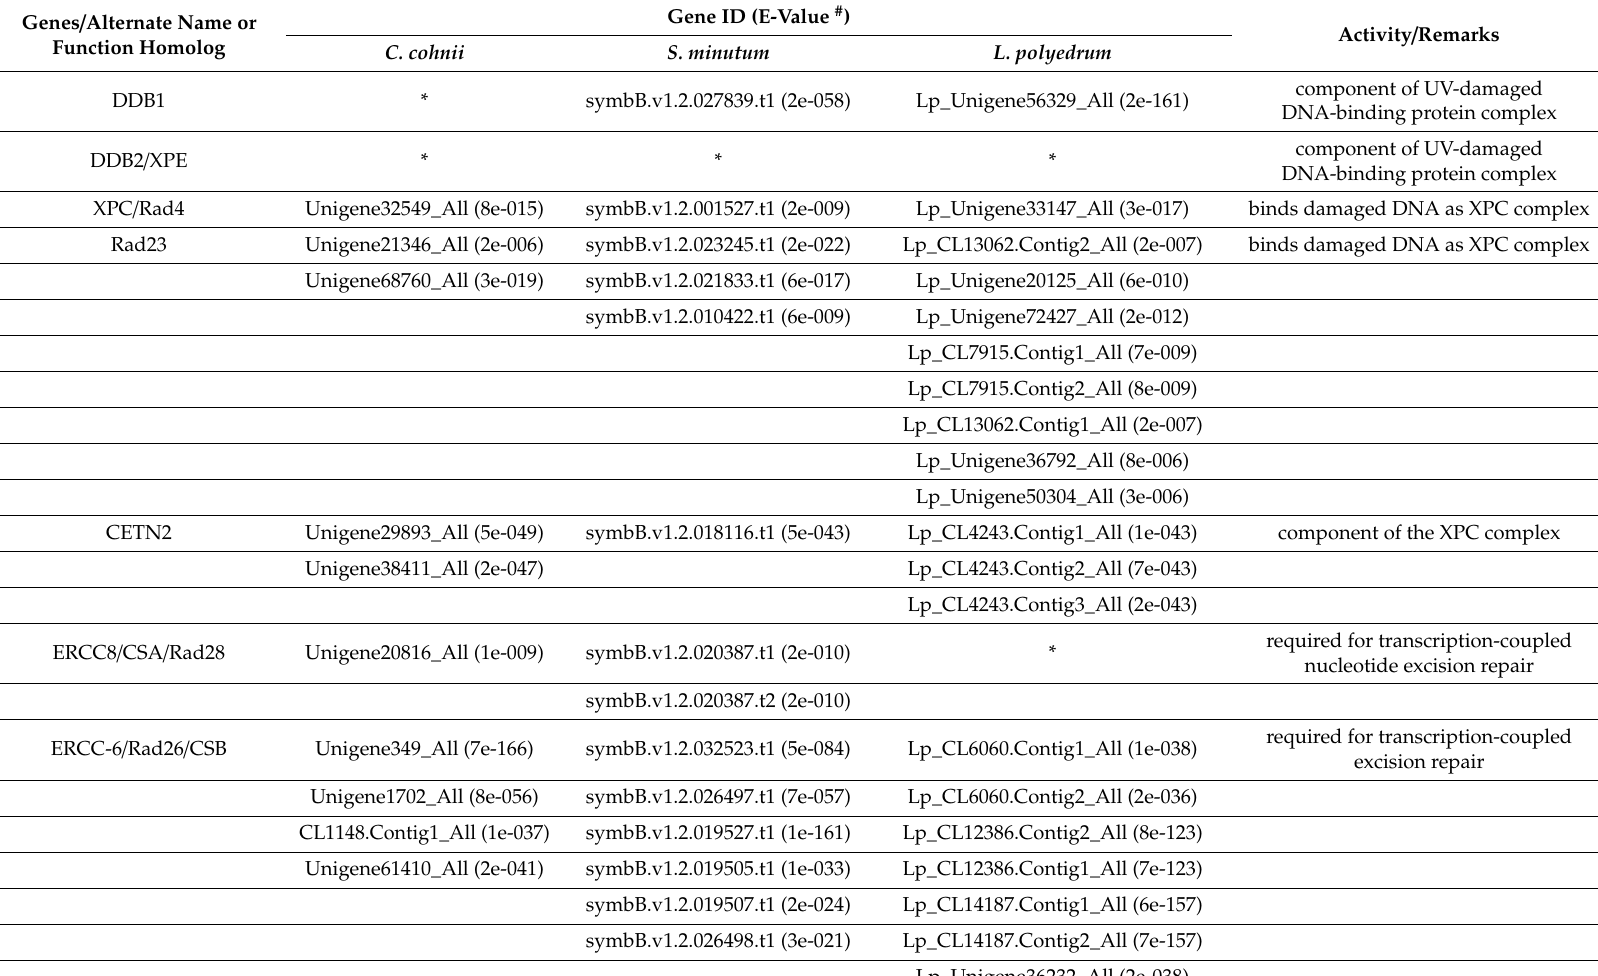
Table 4. Predicted dinoflagellate orthologues in nucleotide excision